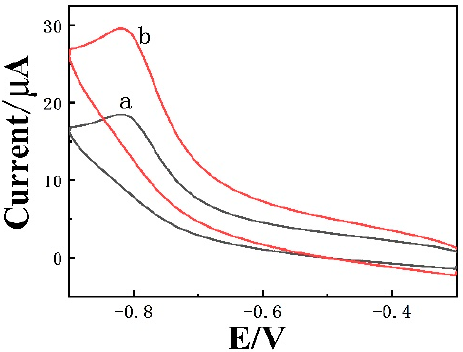
Figure 6. Cyclic voltammograms of 100 μ mol·L − 1 4-NP of bare GCE (a) and CLR-PC/GCE (b) in 0.1 mol·L − 1 phosphate buffer (pH = 6).